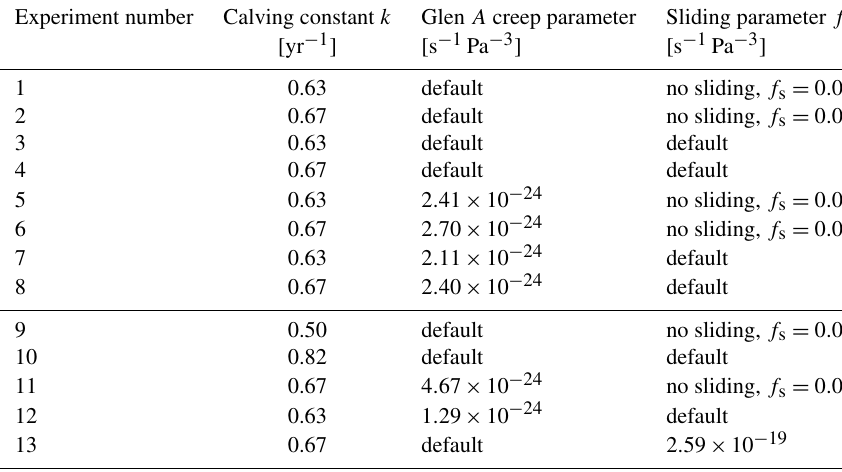
Table 1. Different model configurations applied to marine-terminating glaciers of Alaska.